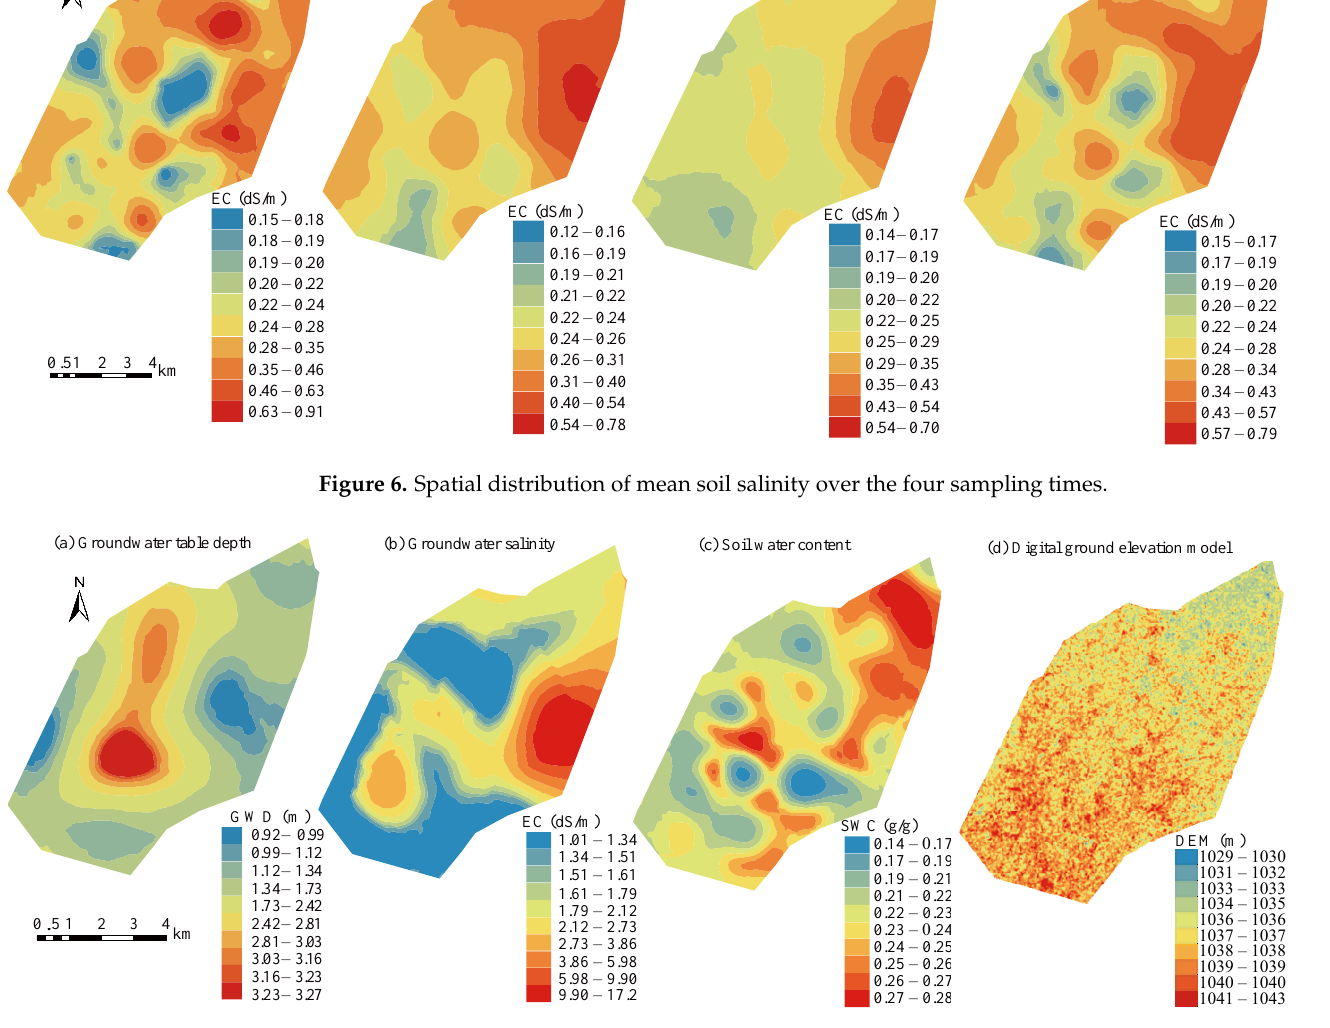
Figure 7. Spatial distribution of environmental factors including ( a ) groundwater table depth (GWD), ( b ) groundwater salinity (GWS), ( c ) soil texture represented by soil water content (SWC), and ( d ) digital ground elevation model (DEM).